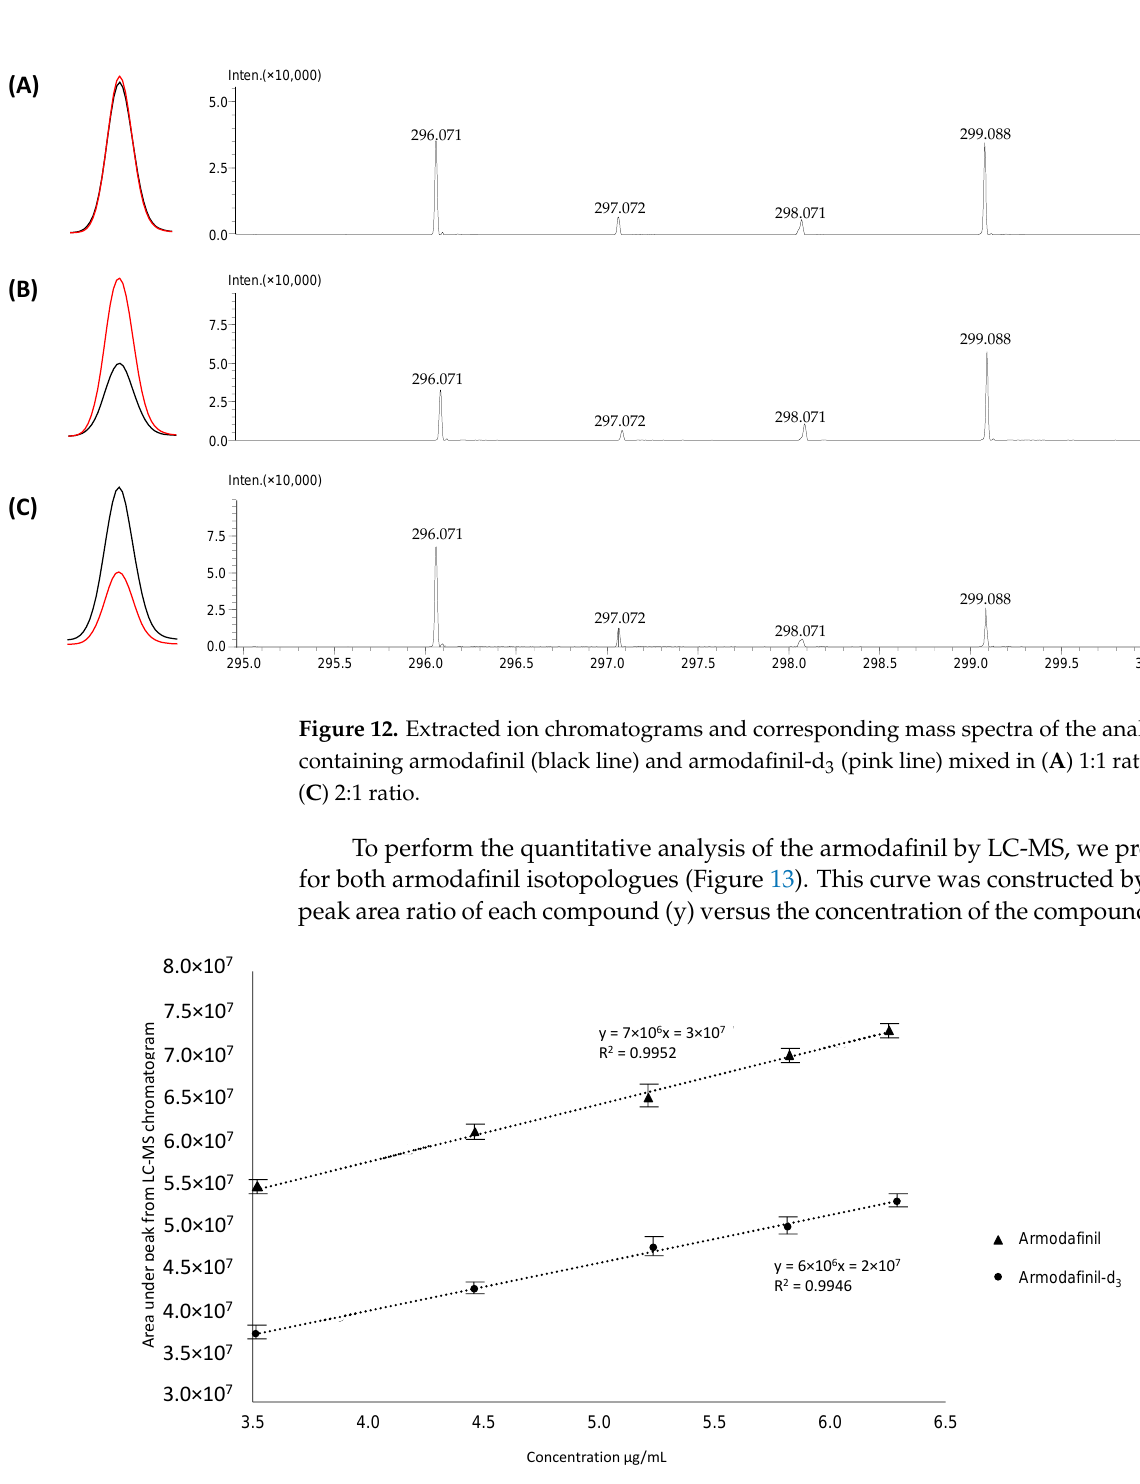
Figure 13. Calibration curve of non-deuterated armodafinil and armodafinil-d 3 . The human urine samples collected after 3, 4, 5, 6, 8 and 24 h after taking 200 mg of armodafinil by one patient were analyzed. The obtained results are presented in the Figure 14. The maximum concentration of armodafinil after single-dose was found in the urine sample collected after 5 h of its taking, at the level of 5.3 µ g/mL. It was observed that armodafinil is readily absorbed after oral administration and also readily